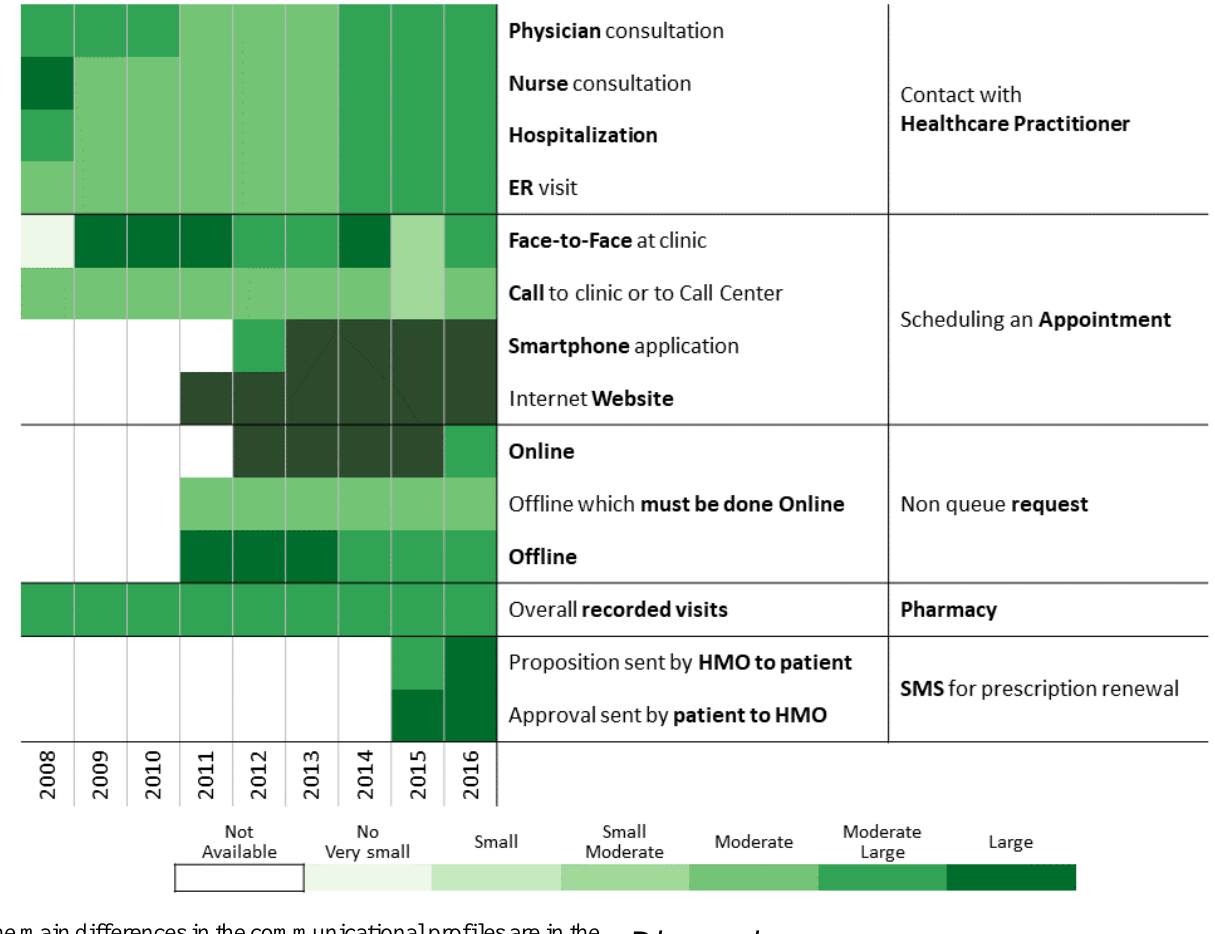
Figure 19. Communication pattern changes between 2008 and 2016 for patients with diabetes leading electronic-driven interaction with the health management